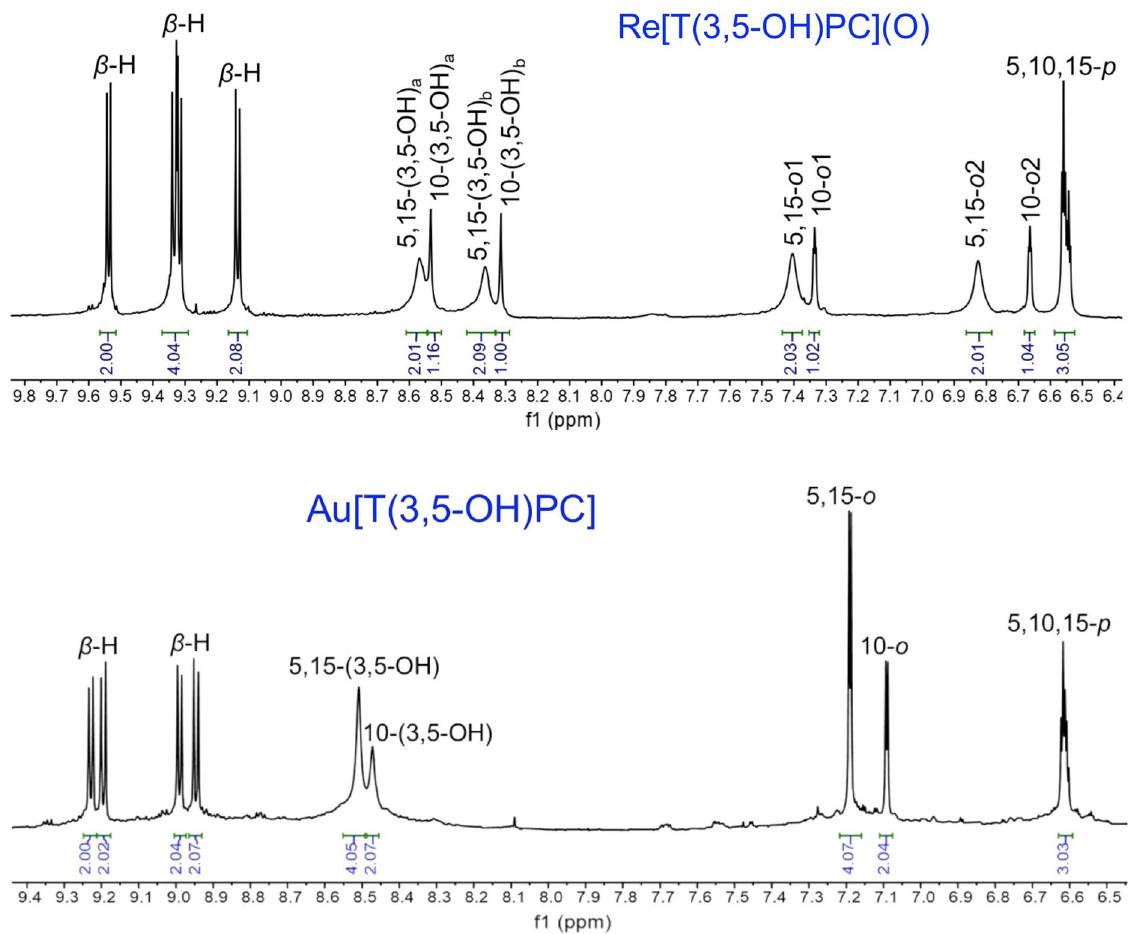
Figure 3. 1 H NMR spectra of M[T(3,5-OH)PC] in THF- d 8 : M = ReO (above) and Au (below).